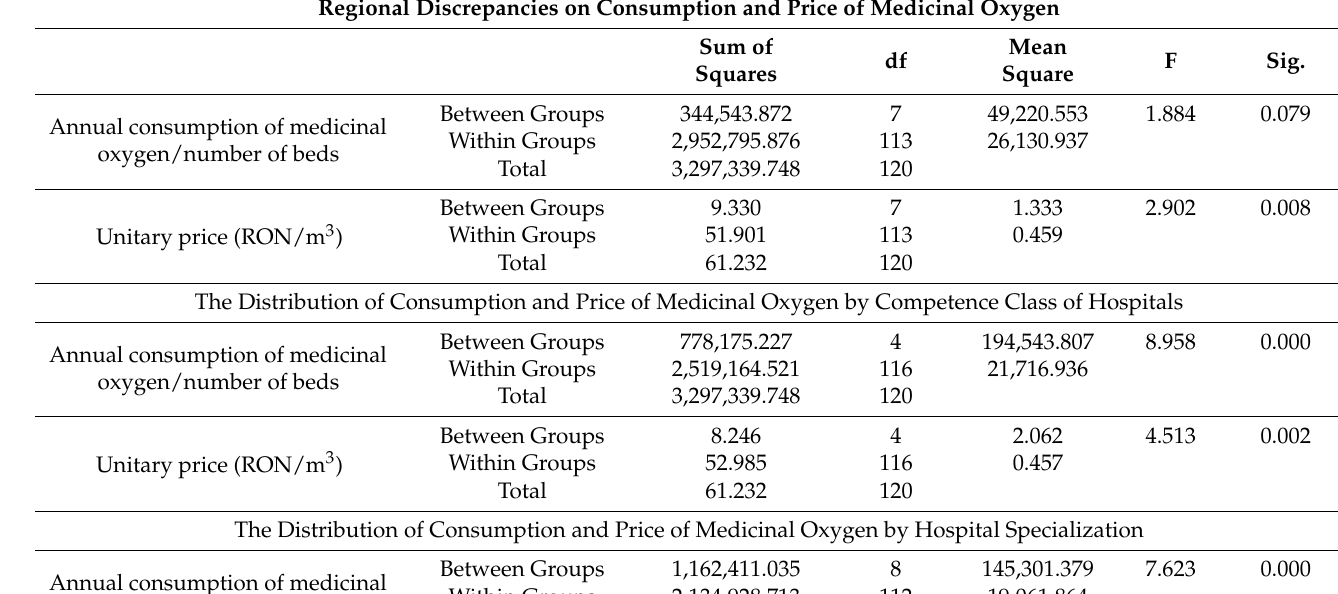
Table 2. The empirical results of the analysis of variance (ANOVA) for regional discrepancies in consumption and price of medicinal